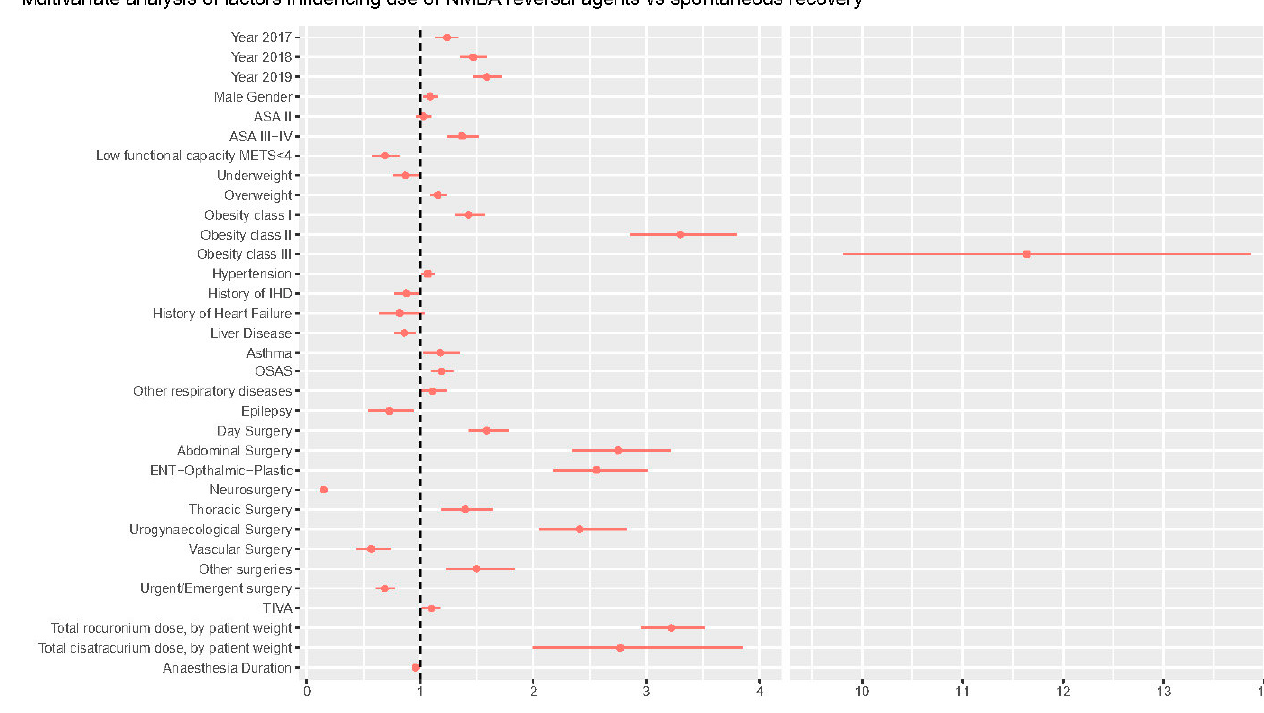
Figure 2. Time trends in NMBA reversal practice.